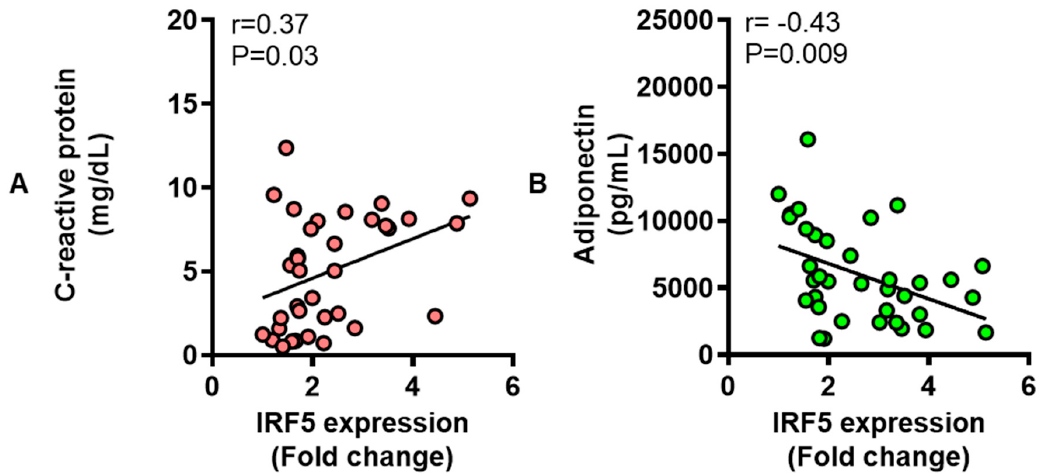
Figure 8. Adipose interferon regulatory factor-5 (IRF5) gene expression correlates with the circulatory C-reactive protein (CRP) and adiponectin levels. Plasma levels of CRP and adiponectin were measured in 35 individuals including lean, overweight, and obese by ELISA as described in Materials and Methods. The data (mean ± SEM) show that ( A ) adipose expression of IRF5 correlated positively